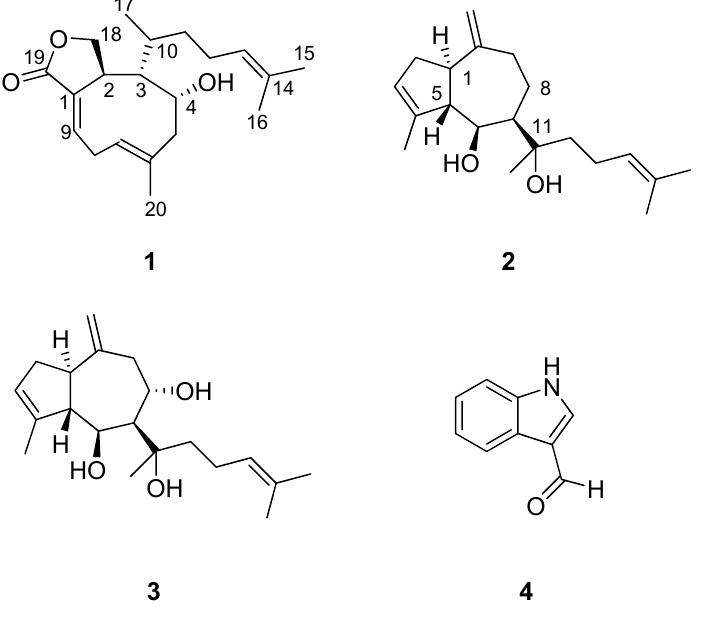
Figure 1. Structures of the xenicane lactone 4-hydroxydictyolactone ( 1 ), the diterpenes dictyol E ( 2 ) and 8  ,11-dihydroxypachydictyol A ( 3 ), and indole-3-carboxaldehyde ( 4